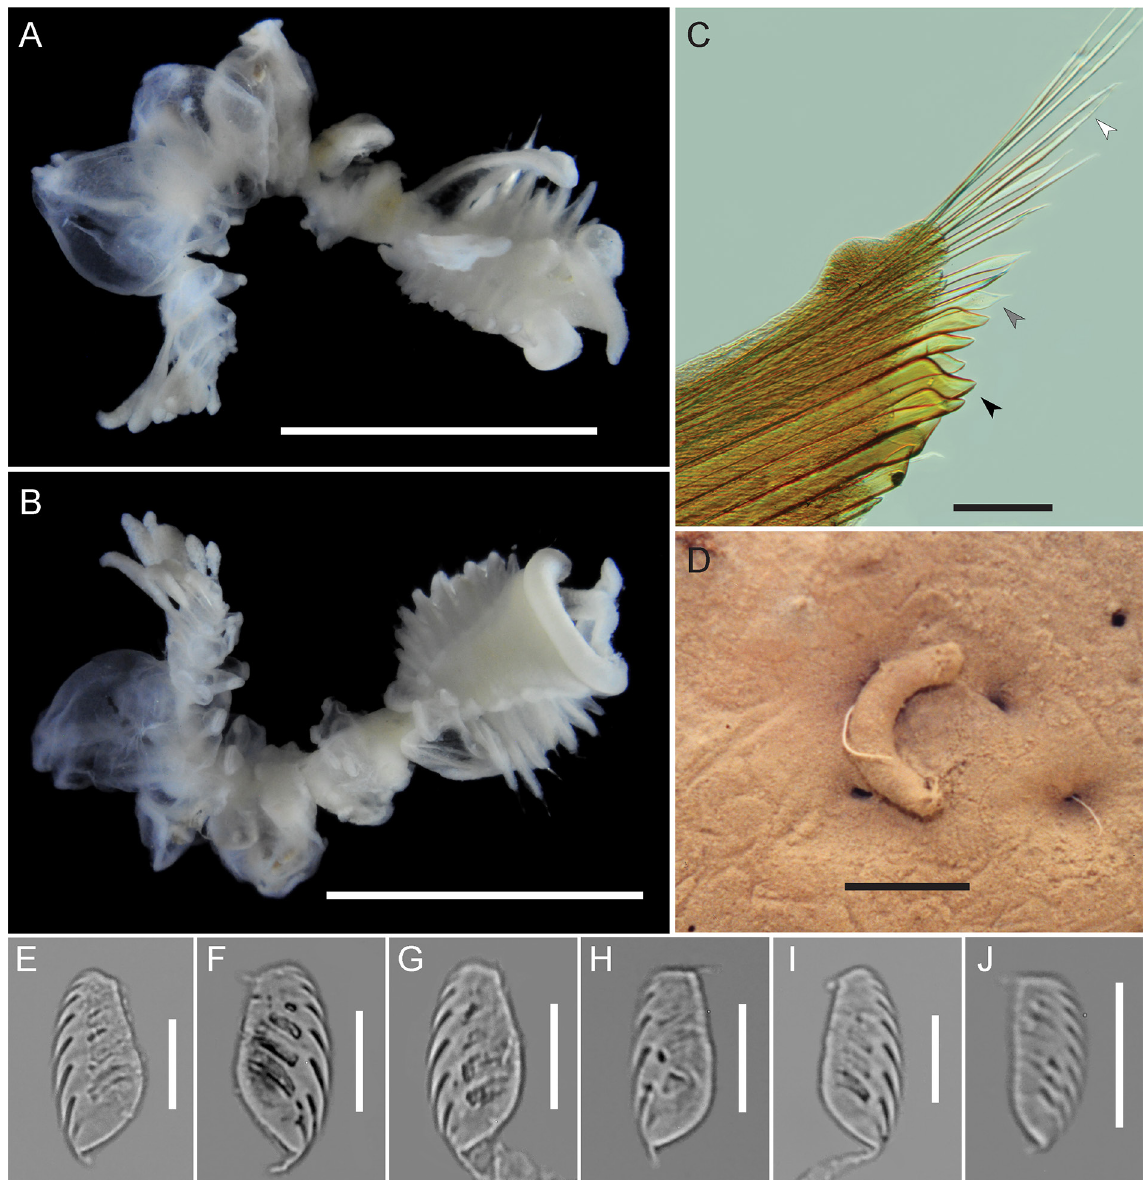
Fig. 2. Chaetopterus bruneli sp. nov. A . Latero-dorsal view of holotype CMNA 2015-0016. B . The same in ventral view. C . A4 notopodium of paratype CMNA 2015-0010; white arrow: simple terminal notochaetae, grey arrow: lanceolate simple chaetae, black arrow: stout specialised cutting chaetae. D . In situ tube of Chaetopterus bruneli sp. nov. in the St. Lawrence Estuary at a depth of 350 m, specimen not collected. E–J . Uncini sampled from paratype specimen CMNA 2015-0018. E . Uncinus of B1 anterior neuropodial lobe. F . Uncinus of B1 posterior lobe. G . Uncinus of B3 piston torus. H . Uncinus of B3 ventral lobe. I . Uncinus of C1 lateral lobe. J . Uncinus of C1 ventral lobe. Scale bars: A–B = 5 mm; C = 200 µm; D = 1 cm approx.; E–J = 20